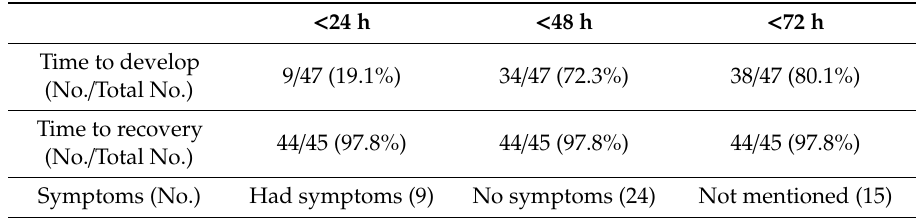
Table 2. The time of all patients to develop or recovery from chylous ascites / e ffl uent after taking calcium channel blockers.